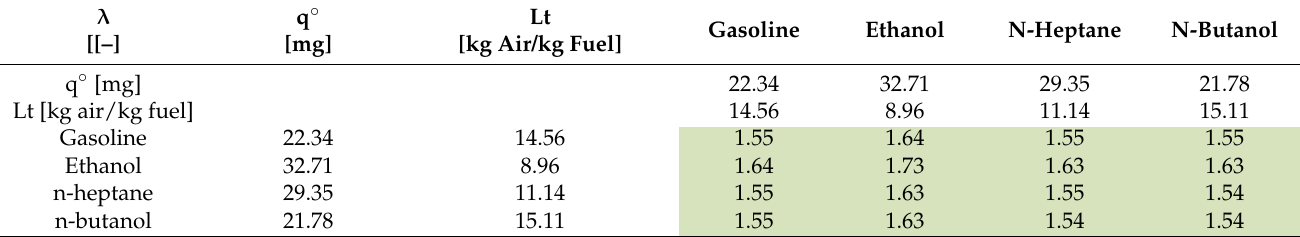
Table 6. Determining the global excess air coefficients of the analyzed